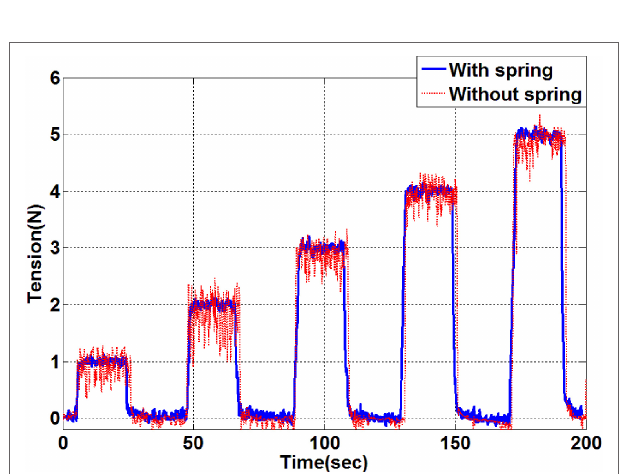
FigUre 6 | Tension control results by applying target tensions between 1 and 5 n . The resulting tension in the evaluation with a spring is indicated by the blue line and the tension result without a spring is shown as the red line.